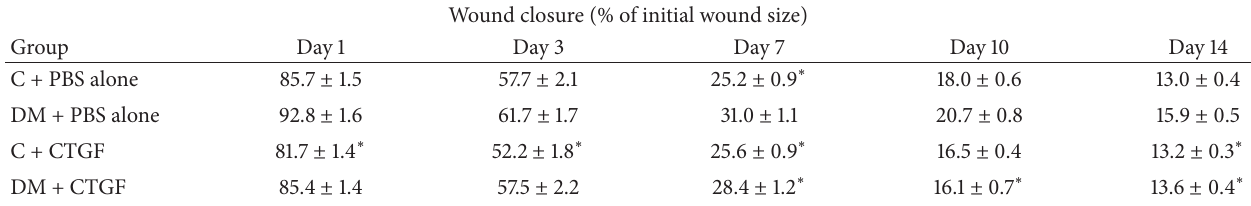
Table 1: Wound closure data in diabetic and nondiabetic (control) rats, each treated with topical rhCTGF or PBS